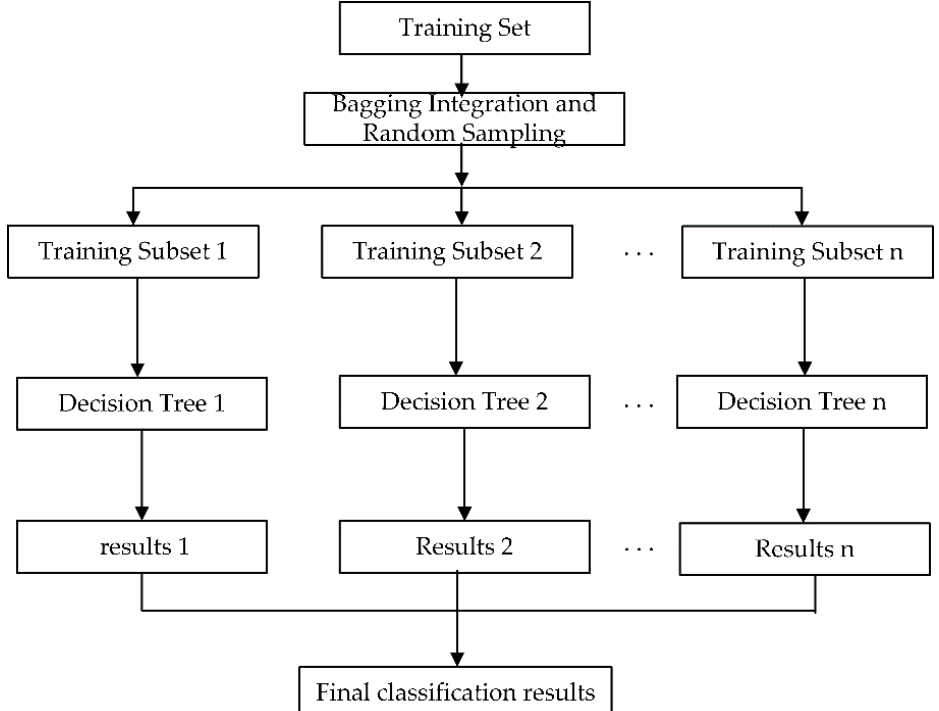
Figure 9. Steps of random forest construction.